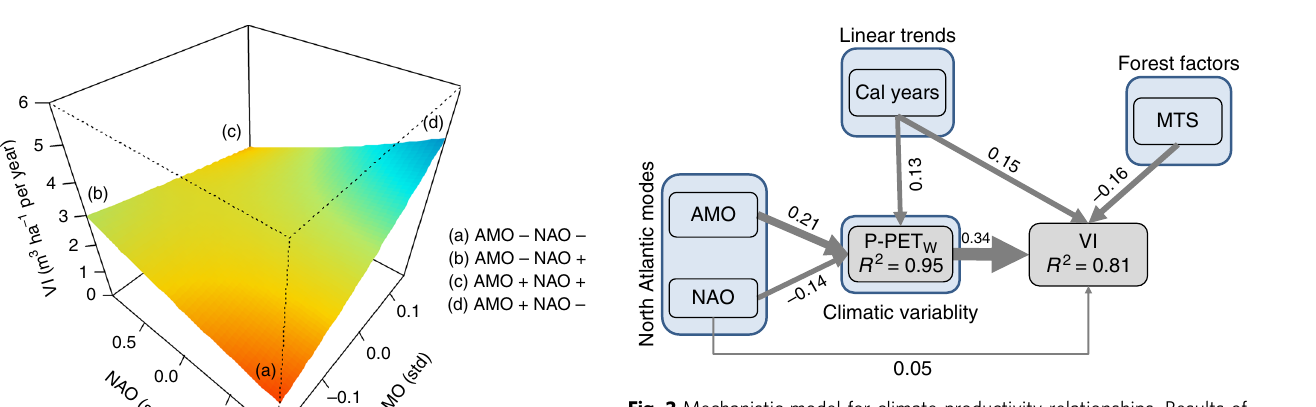
Fig. 2 Mechanistic model for climate-productivity relationships. Results of the Structural Equation Models (SEMs) exploring the effects of North Atlantic modes (NAO and AMO) and last-century linear trends (calendar year) on the winter water balance (P-PET), and the effects of mean tree size (MTS) and local climatic variability (winter water balance, P-PET) on wood volume increments (VI, as surrogate of forest productivity). An unaccounted link between NAO and VI was included after evaluation of potential missing paths in the initial hypothesis. Boxes represent measured variables and arrows unidirectional relationships among variables. Only signi fi cant paths ( P ≥ 0.05) among all possible paths are shown. The thickness of the signi fi cant paths has been scaled based on the magnitude of the standardized regression coef fi cient (showed beside arrows). R 2 conditional for the forest productivity model (based on the variance of both the fi xed and random effects) is given within the P-PET and the VI